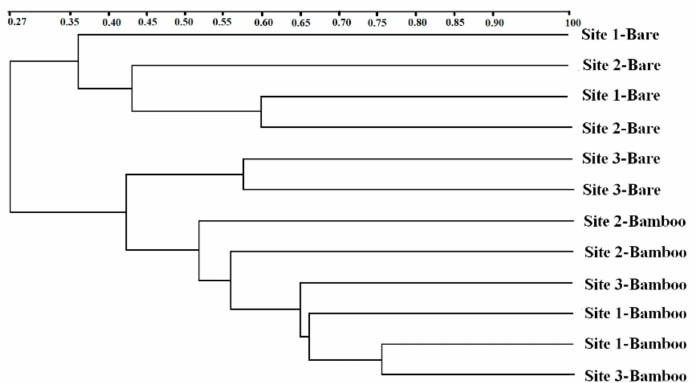
Figure 5. Cluster analysis of bacterial community structures from the soils studied at di ff erent locations measured by the unweighted pair group method with arithmetic mean.